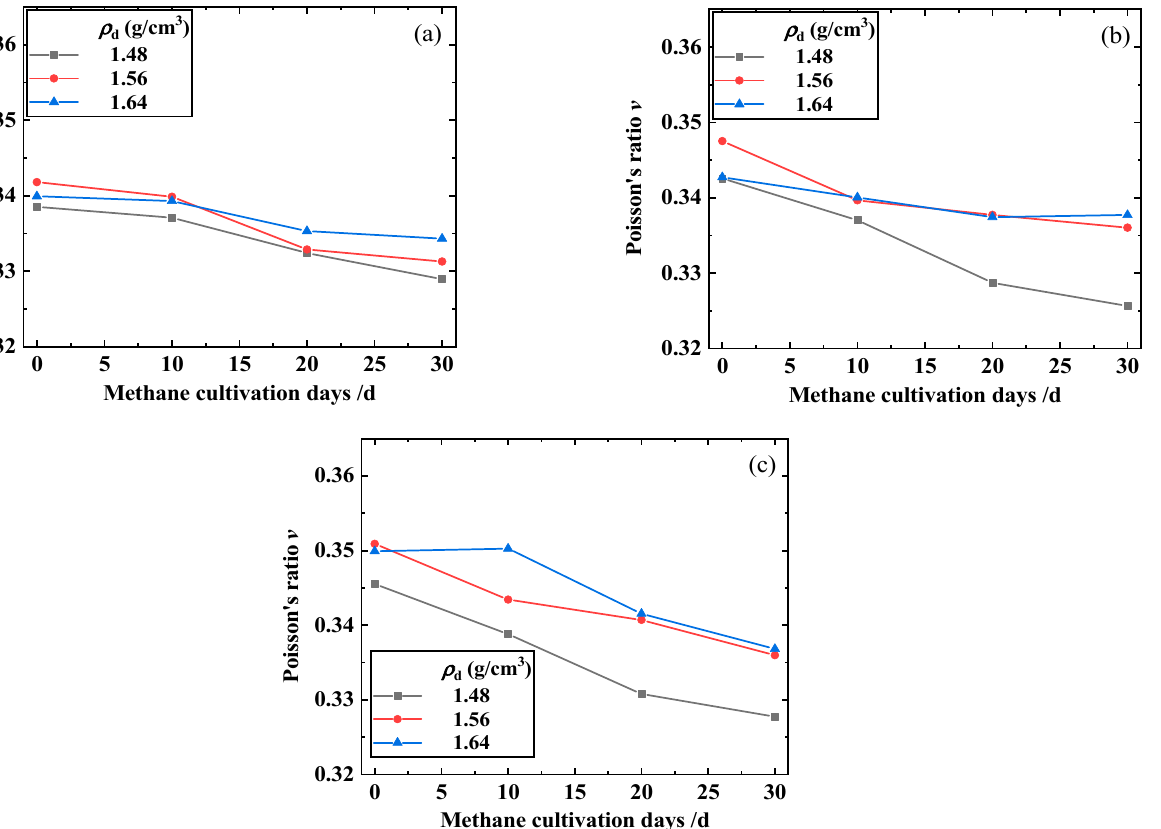
Figure 13. Relationship between Poisson’s ratio and methane cultivation days of the biochar–methanotroph–clay mixture, under different biochar contents: ( a ) α = 0%; ( b ) α = 10%; ( c ) α = 15%.